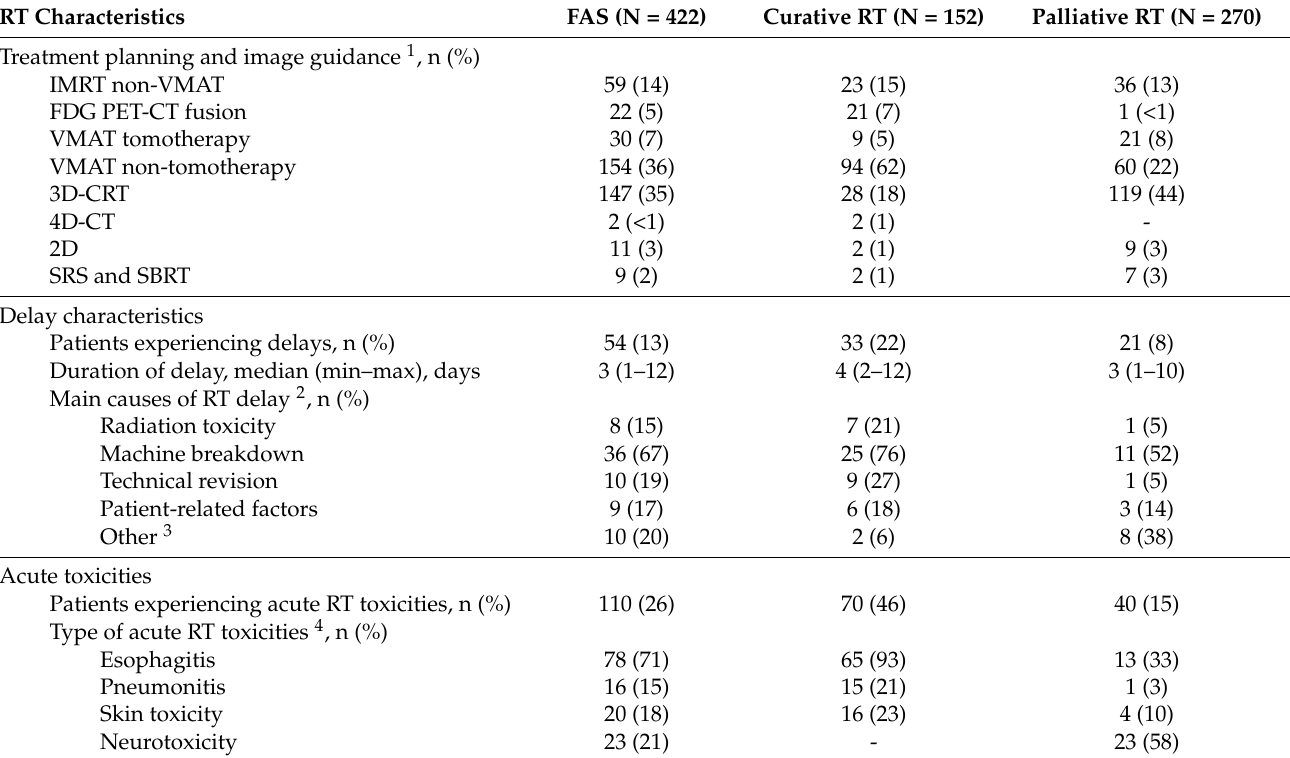
Table 3. RT characteristics in the overall set, curative, and palliative RT